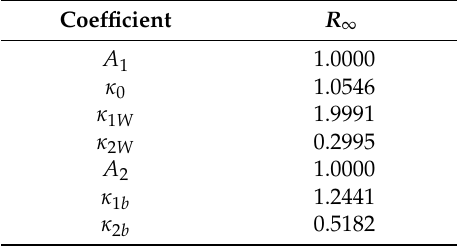
Table 3. Coefficients of the Albert-Mobley model for the finite medium depth